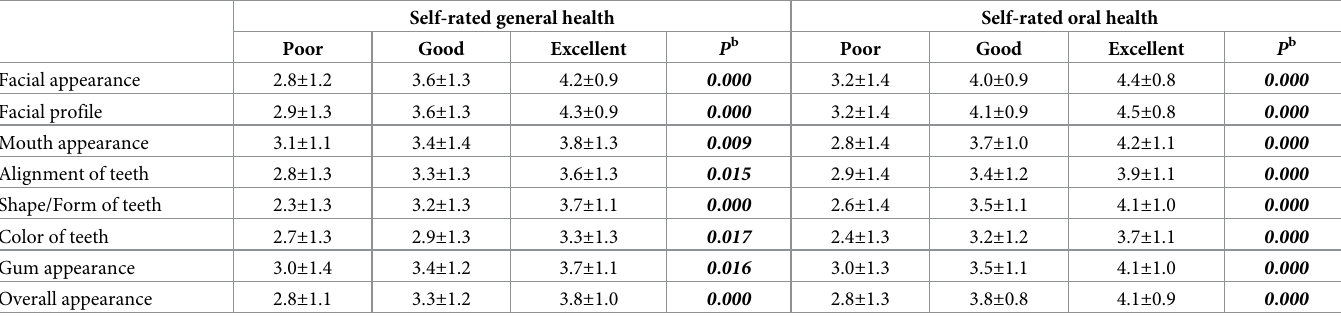
Table 5. Responses to OES-Ar questionnaire according to self-rated oral health and general health